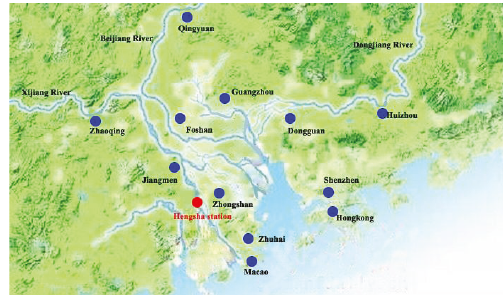
Figure 1: Map of the Guangzhou section of the Pearl River under